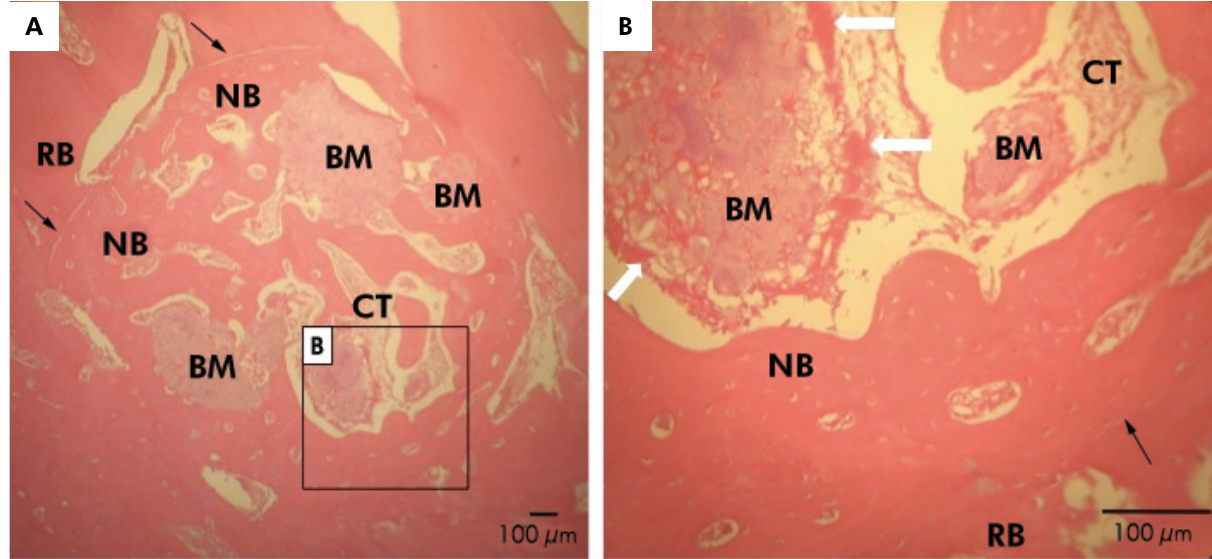
Figure 4. Representative photomicrographs of the HA group. Defect area (black arrow); newly formed bone (NB); central area of the defect composed of loose connective tissue (CT) with sparse chronic inflammatory infiltrate and few multinucleated giant cells (white arrows) surrounding the biomaterial particles